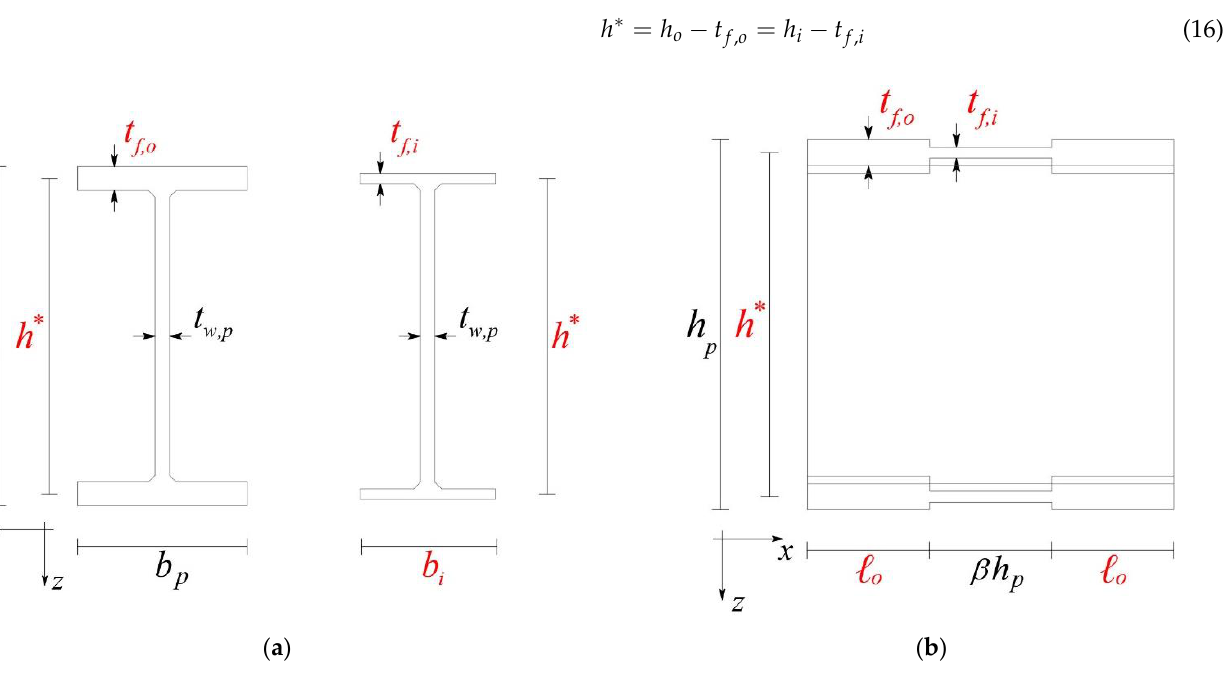
Figure 9. Device geometry and design variables: ( a ) cross sections of the inner and outer portions; ( b ) lateral view.